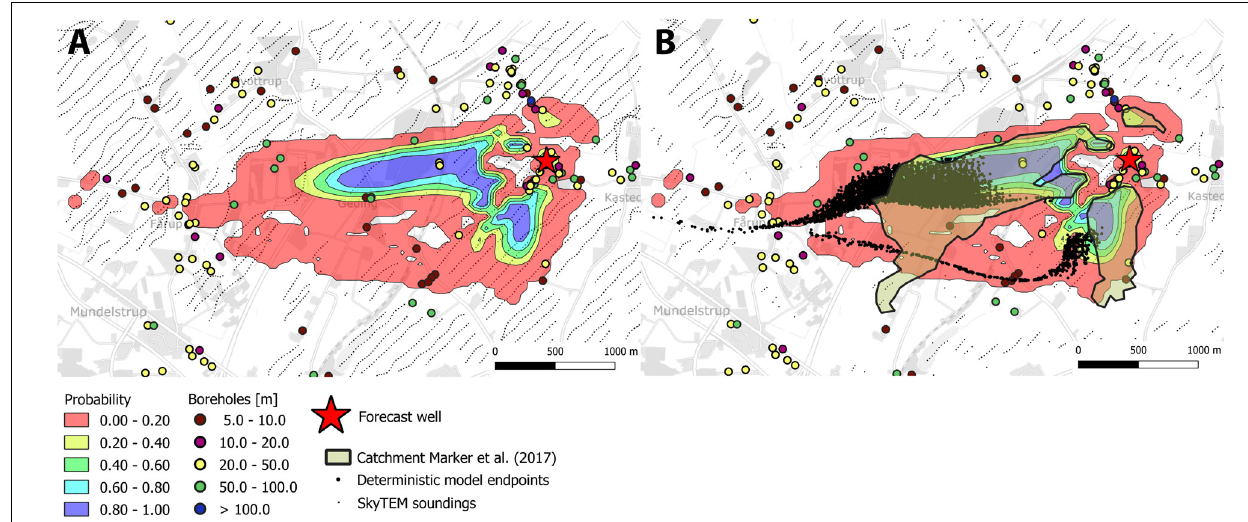
FIGURE 10 | Probability plots of well catchment zones for the Kasted well estimated from the three cluster model realizations. (A) Catchment probability (B) Probability map overlaid with catchment from deterministic model and outline from Marker et al. (2017).